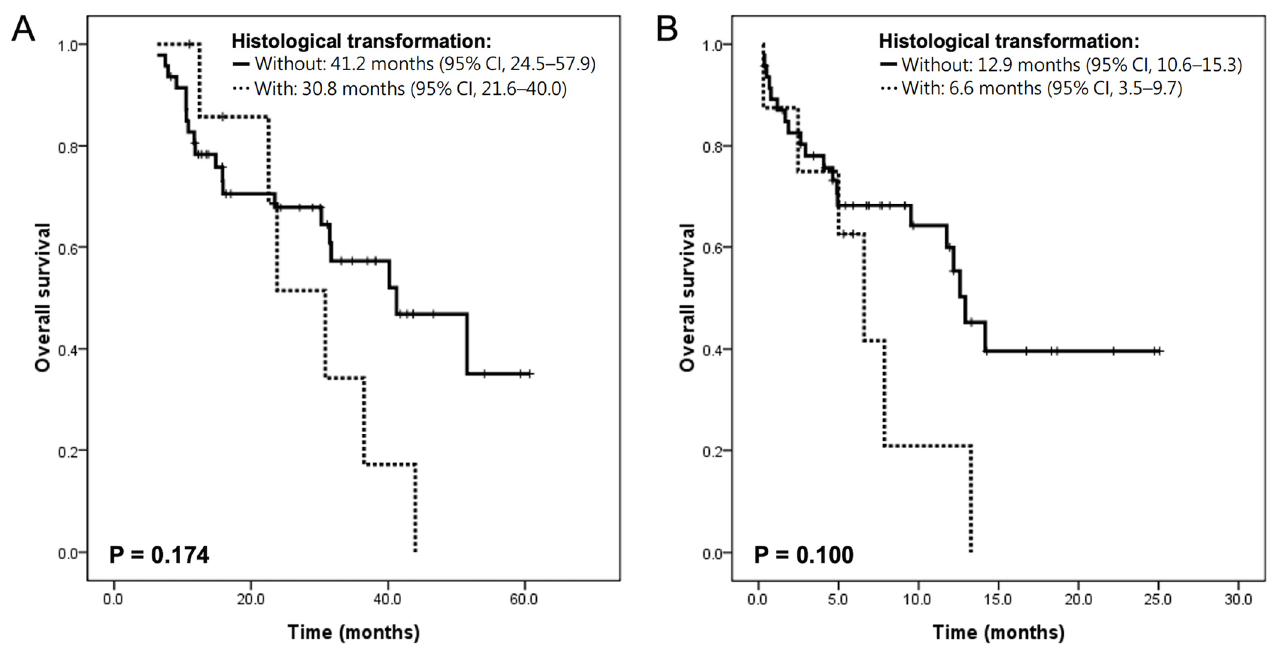
Figure 2. Influence of histological transformation on overall survey. Survival from the start of the third-generation EGFR-TKI to mortality ( A ) or from rebiopsy to mortality ( B ).